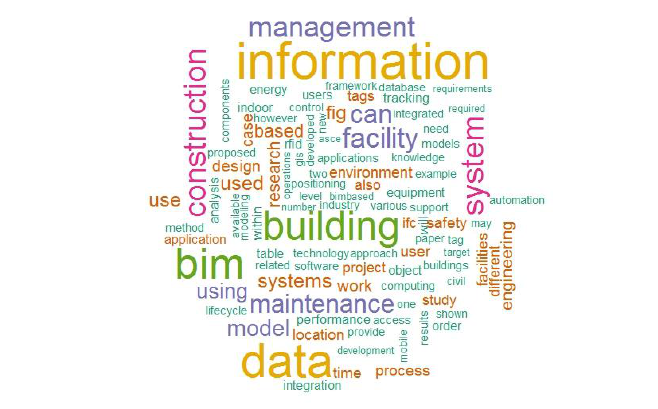
Figure 2: Frequency of occurrence for commonly occurring words (Bar chart View)